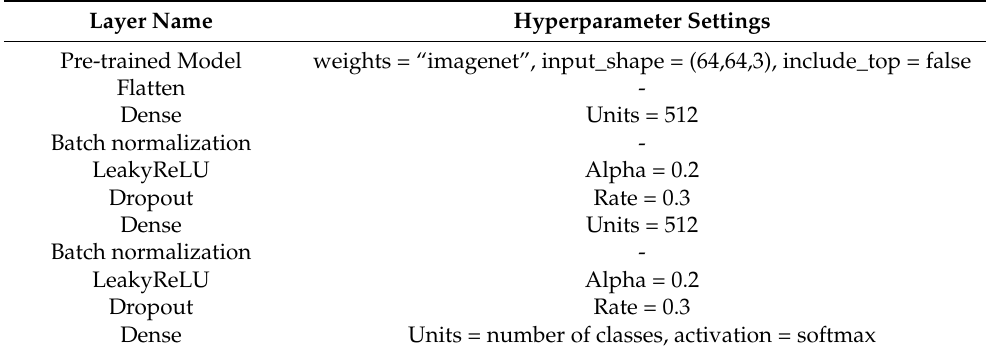
Table 2. Layer name and hyperparameter settings of